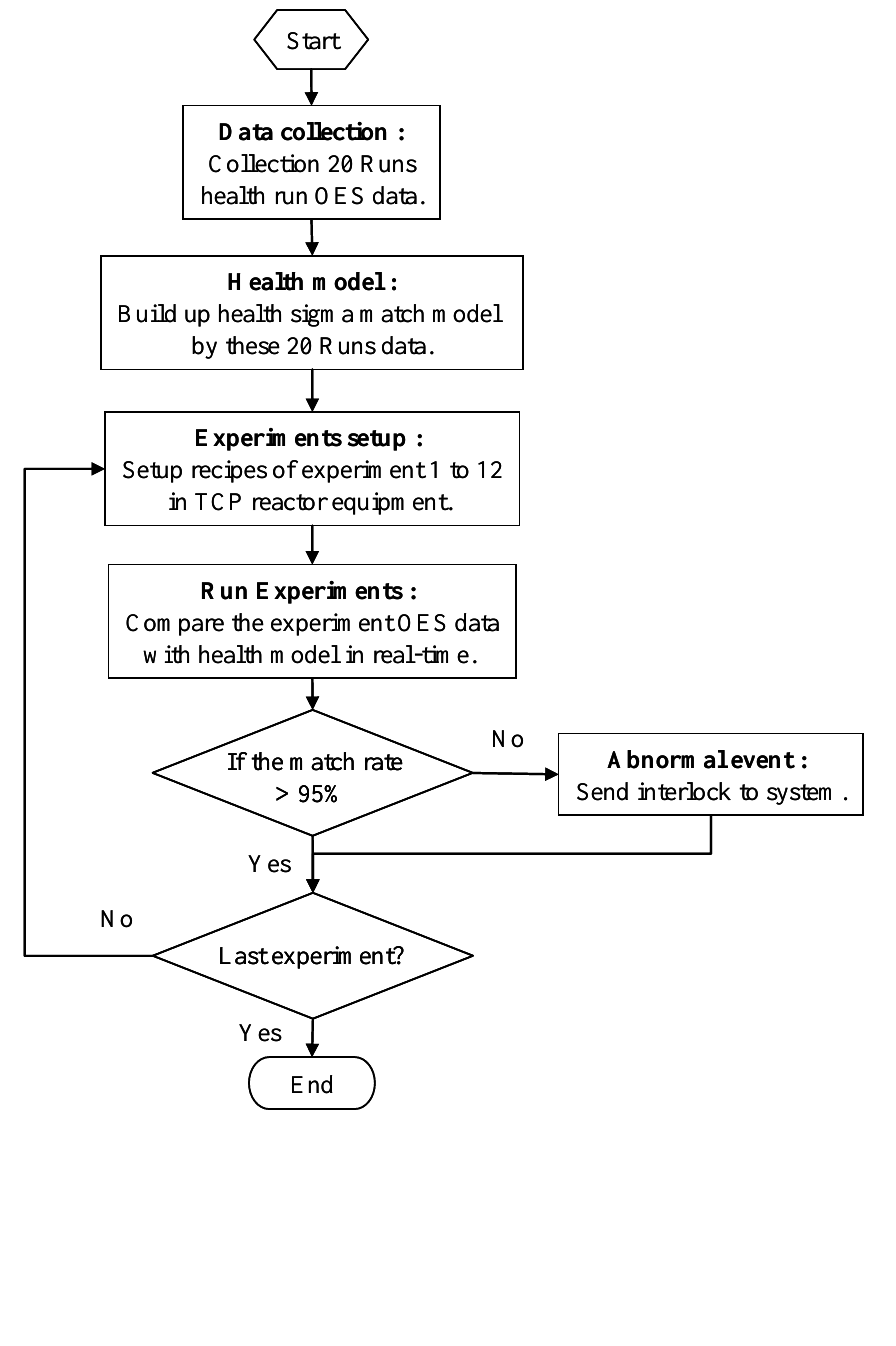
Figure 8. Flowchart of the